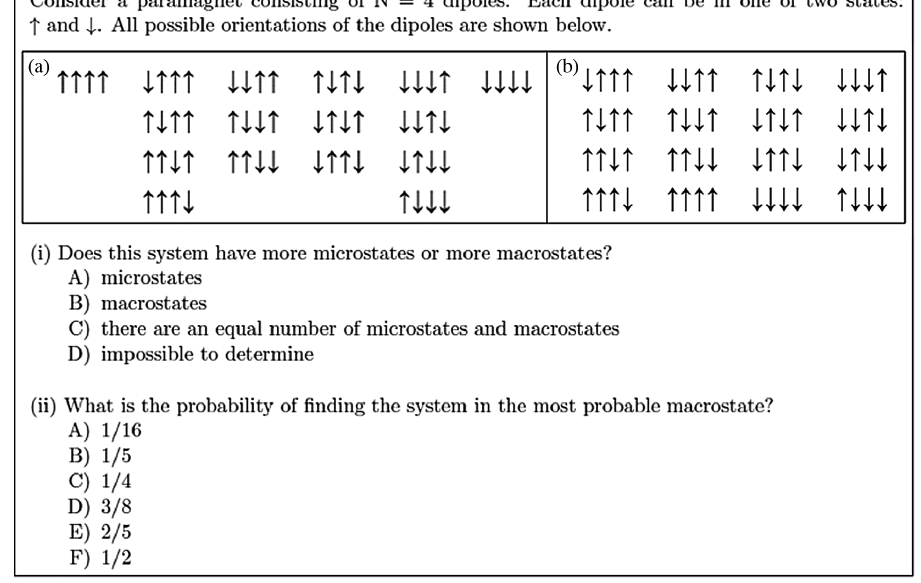
FIG. 3. Item 4 of the U-STEP: (a) The figure presented with the item in Spring 2020 and Fall 2020 and (b) the figure presented in Spring 2021. When the item used (a), a large fraction of students chose C for (ii), which aligns with the longest column being the most probable. After the figure changed from (a) to (b), more students selected D for (ii), increasing both the item difficulty and discrimination drastically (see Table